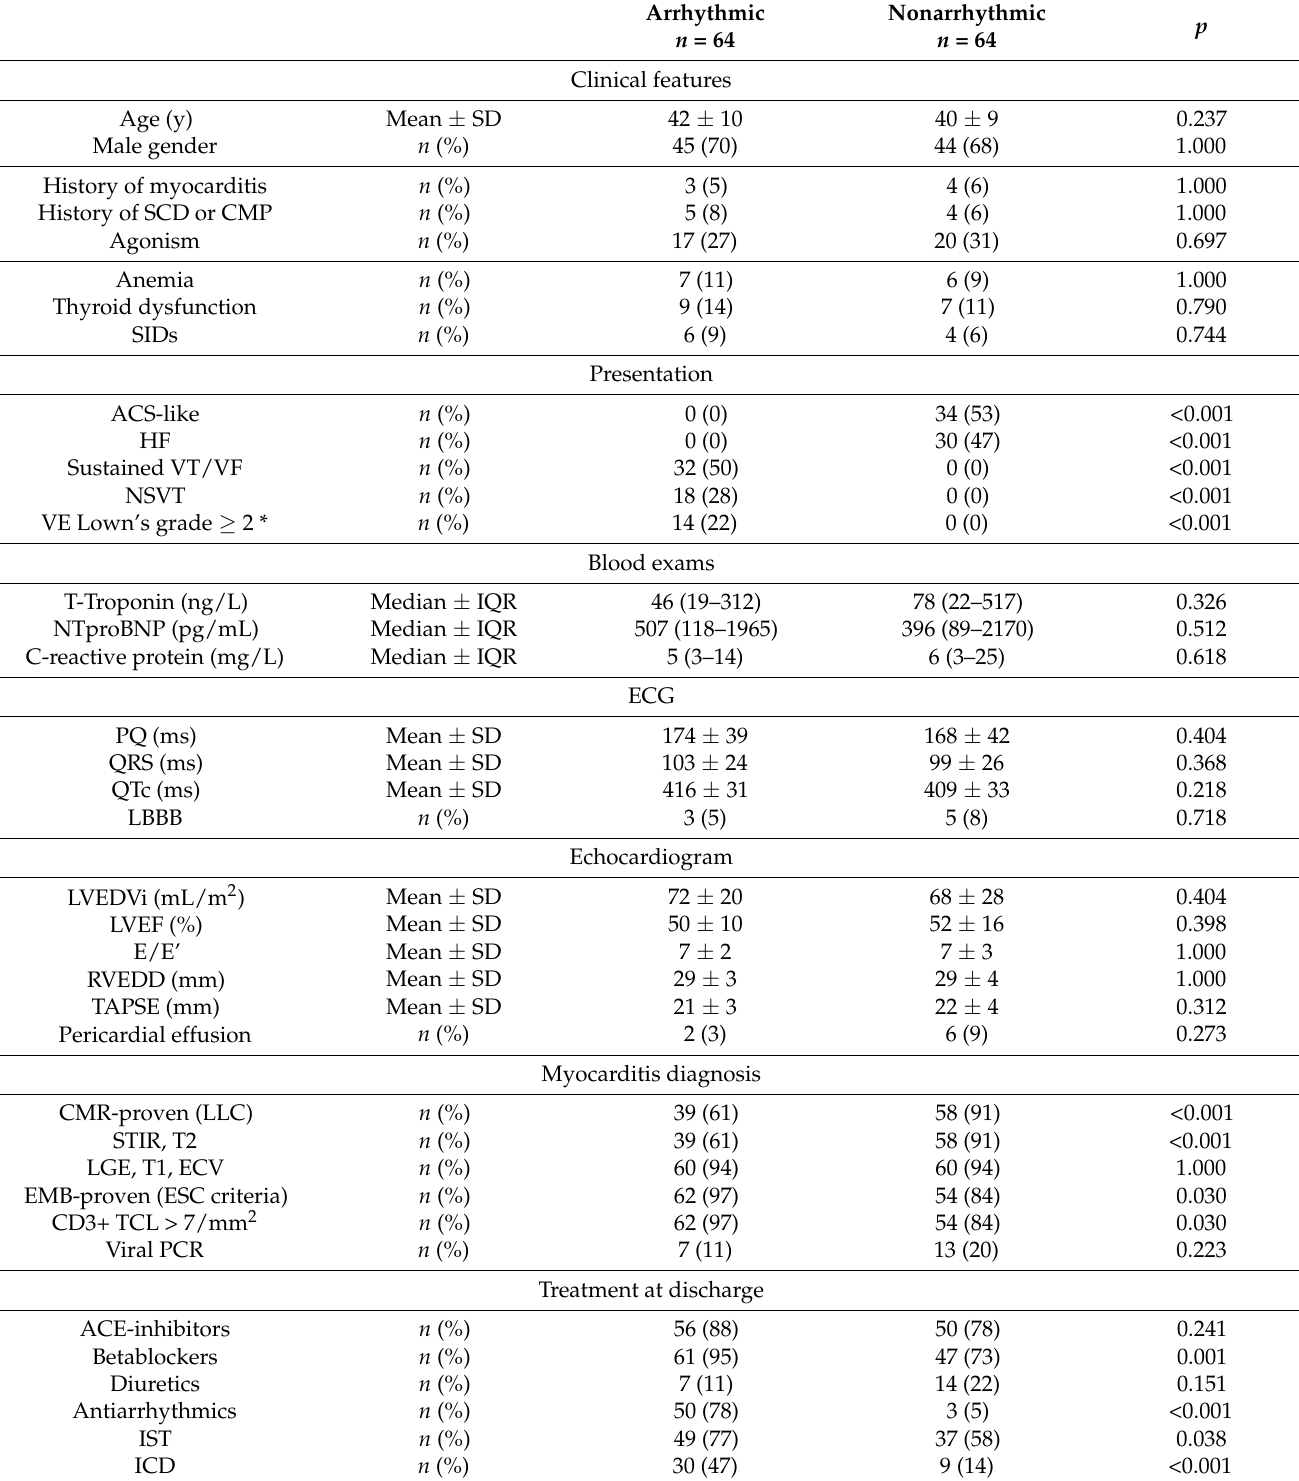
Table 1. Baseline characteristics of population ( n =